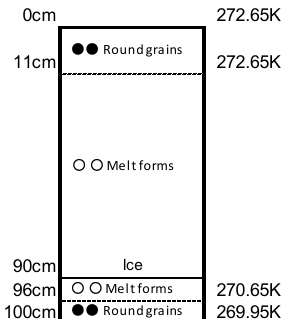
Figure 2. Observed snow stratigraphy and snow temperature in snow pits at the QH3 site on 30 July 2011. The symbols show the snow classification for various layers after Fierz et al. [43], as indicated in the figure legend (Aoki et al. [45]).